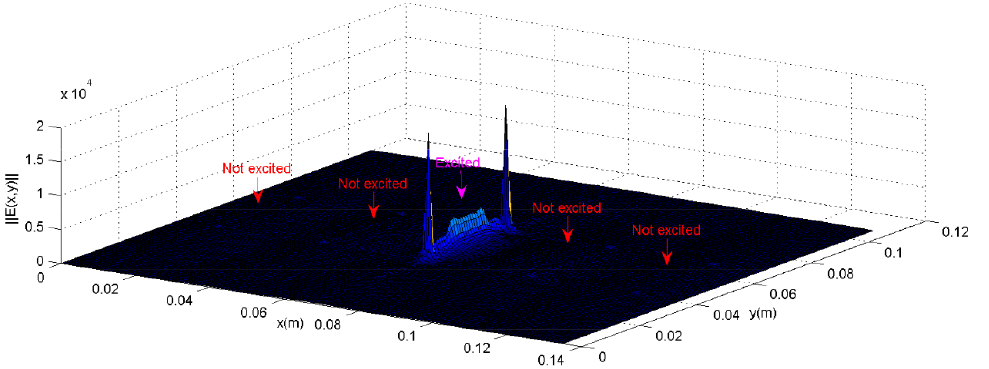
Figure 16. Distribution of the electric density for (5 × 1) aperiodic phased half-wavelength planar dipoles (with (1,0,1,0,1) voltage configuration) described with the basis functions (guide’s modes) at f = 5.4 GHz (using EEEE electric walls).